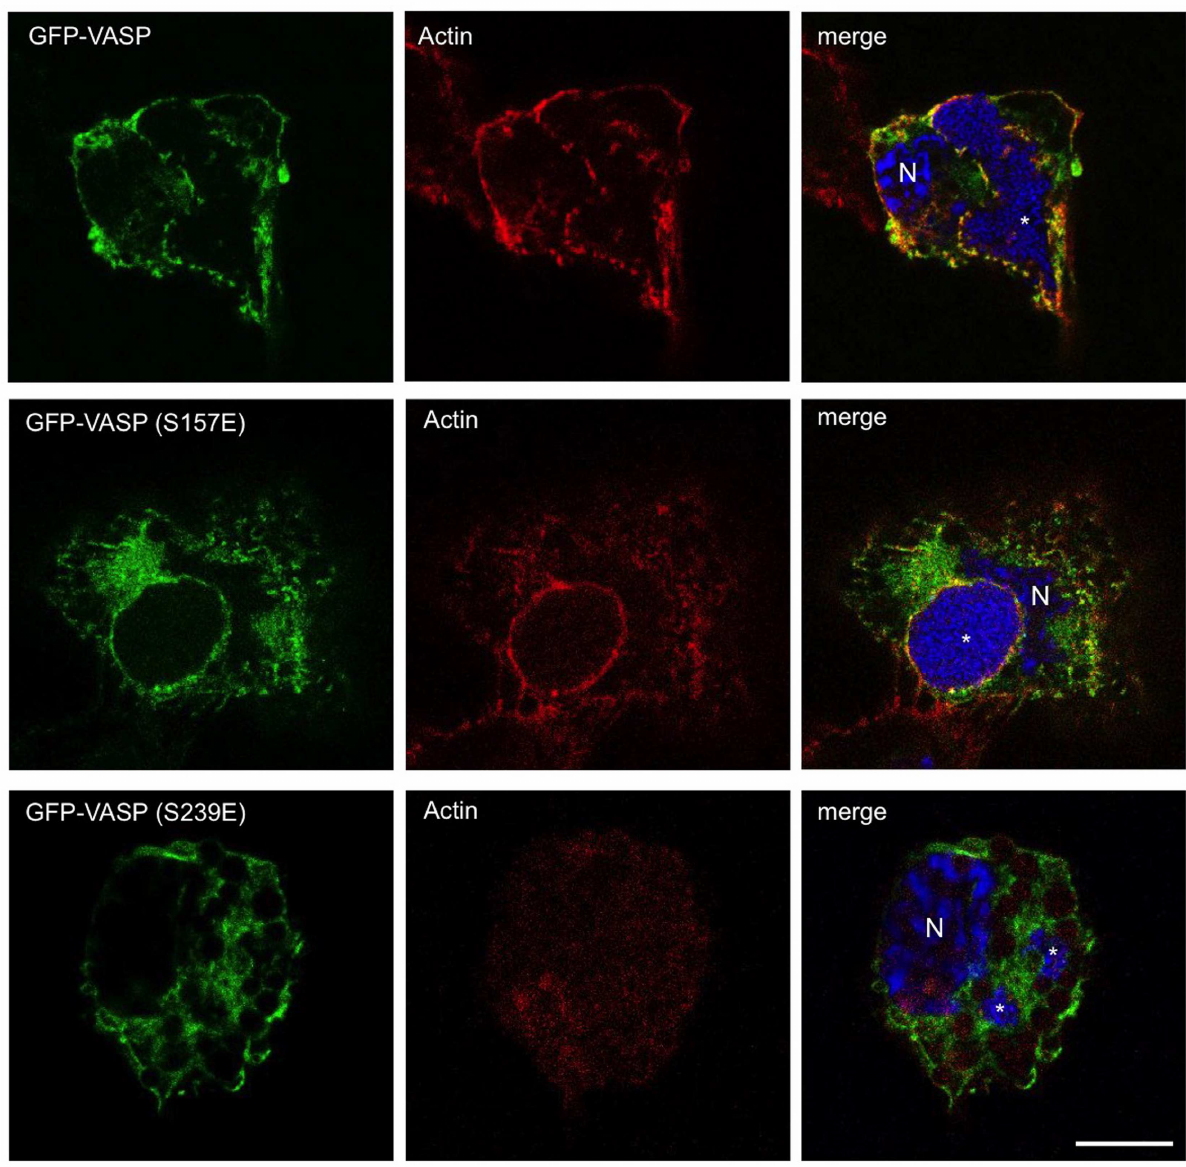
Fig 7. VASP S239E expression interferes with optimal PV formation. THP-1 cells were transfected with constructs encodingGFP- tagged wild type VASP (GFP-VASP), GFP-VASP (S157E), or GFP-VASP (S239E). At 72 hpi, cells were processed for fluorescence microscopy and DNA was stained with DAPI (blue). Actin was labeledwith phalloidin (red). Bar, 10 μ m. N = nucleus and * indicates the PV. GFP-VASP and GFP-VASP (S157E) localizedaround the PV with actin, while GFP-VASP (S239E) expressioninterfered with vacuole expansionand actin